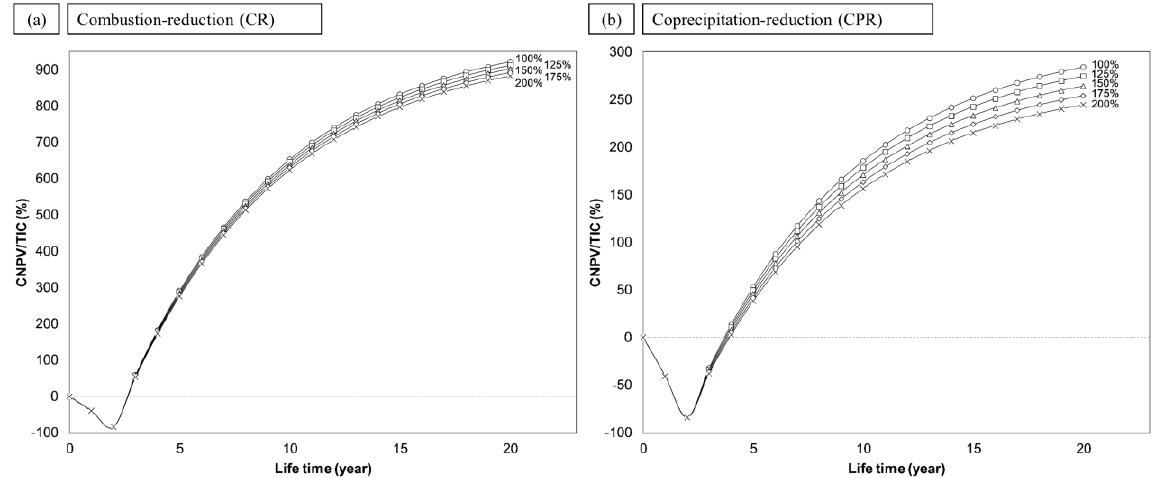
Fig. 10. CNPV/TIC curves in accordance to life time for (a) combustion-reduction (CR) and (b) coprecipitation-reduction (CPR) under various variable costs. An insert image is the analysis of PBP based on variable costs.